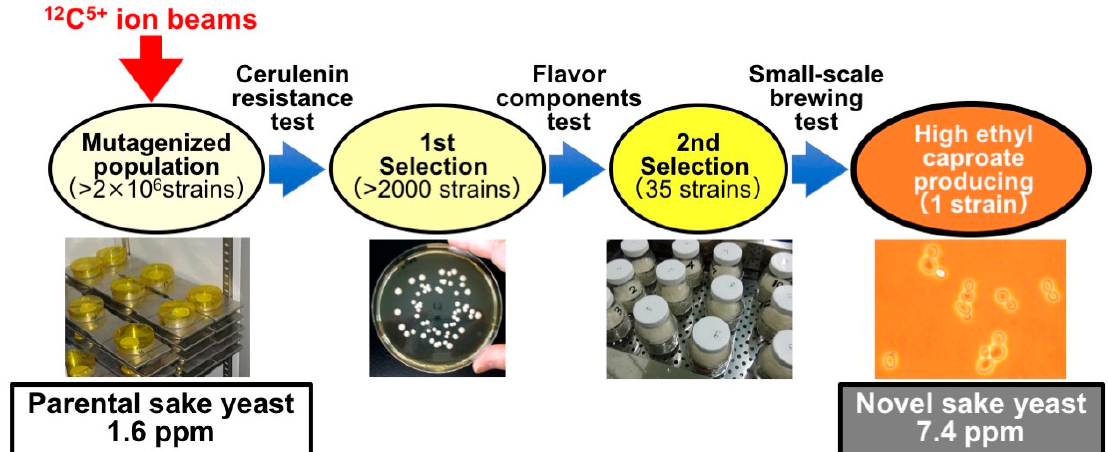
Figure 4. Development of high-ethyl caproate-producing sake yeast ( Saccharomyces cerevisiae ) by ion-beam irradiation. As the first selection, > 2000 cerulenin-resistant mutants were isolated from a mutagenized population of sake yeast, which was generated by carbon-ion-beam irradiation. Next, 35 mutants were selected based on the amount of flavor components produced, including ethyl caproate. Finally, a high-ethyl caproate-producing sake yeast was identified by small-scale brewing tests. The novel sake yeast strain obtained exhibited over four times the ethyl caproate producing ability of the parental strain.